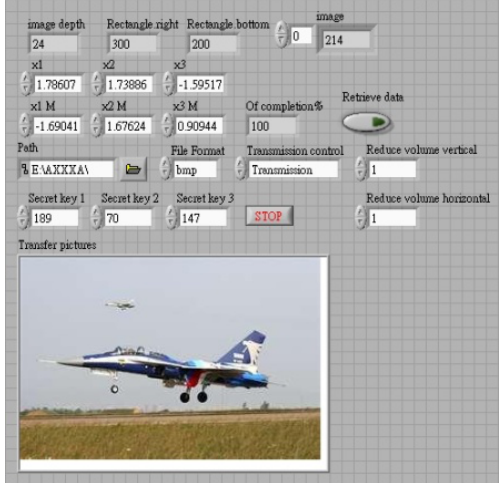
Figure 4. Transmission